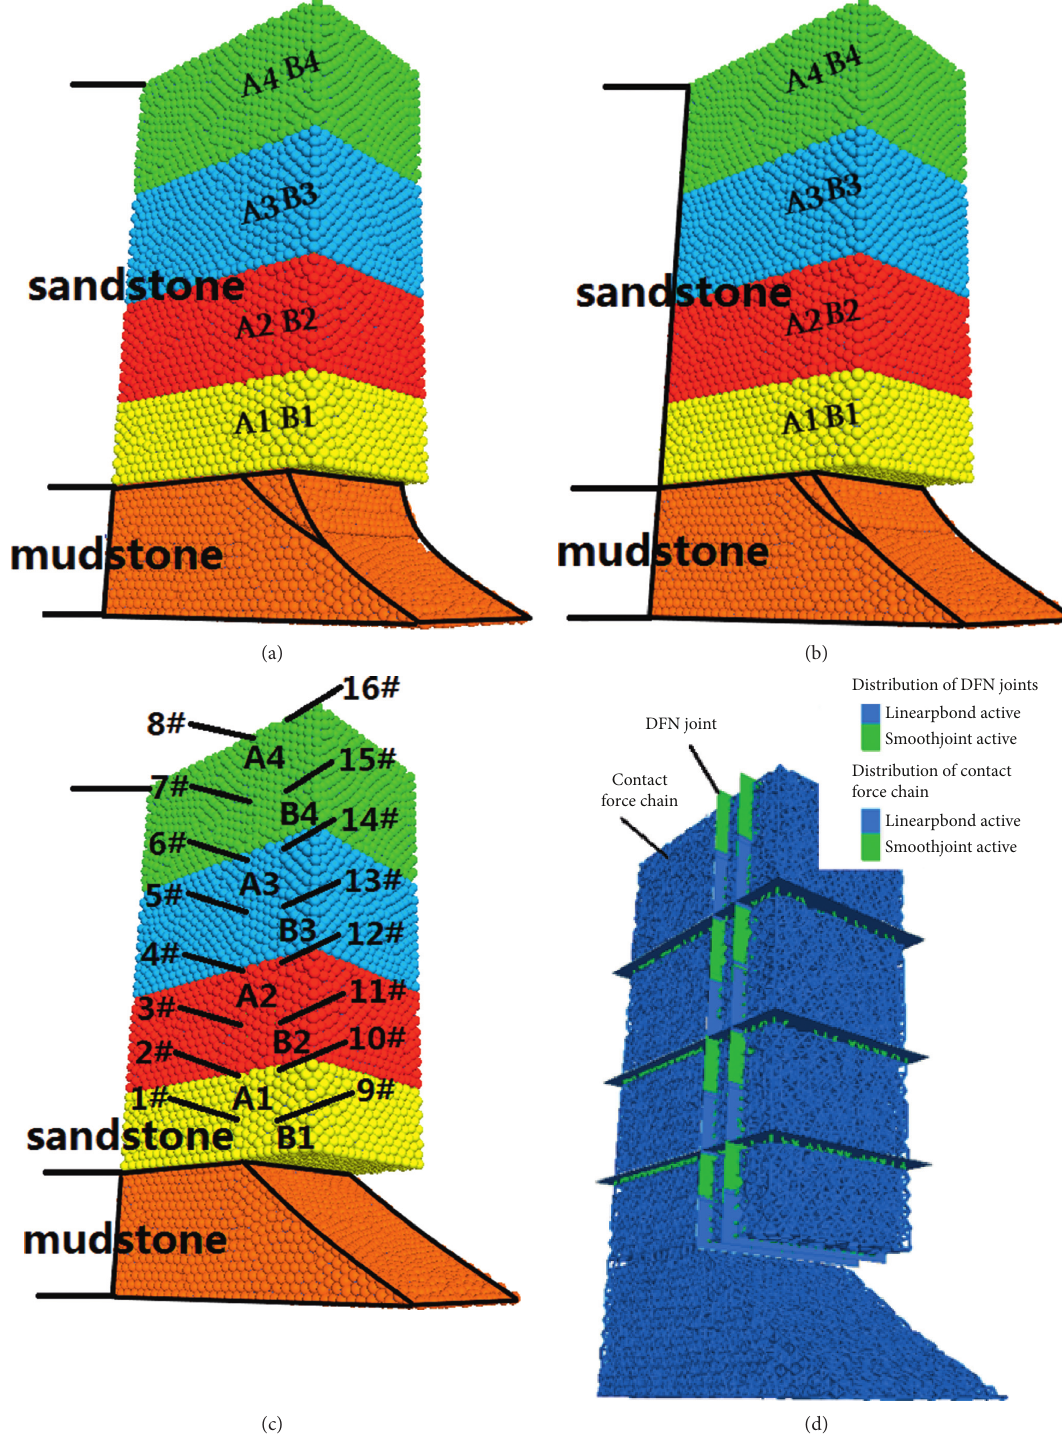
Figure 2: Three-dimensional numerical model of rock cavity type dangerous rock. (a) Model 1. (b) Model 2. (c) Model 3. (d) Contact model